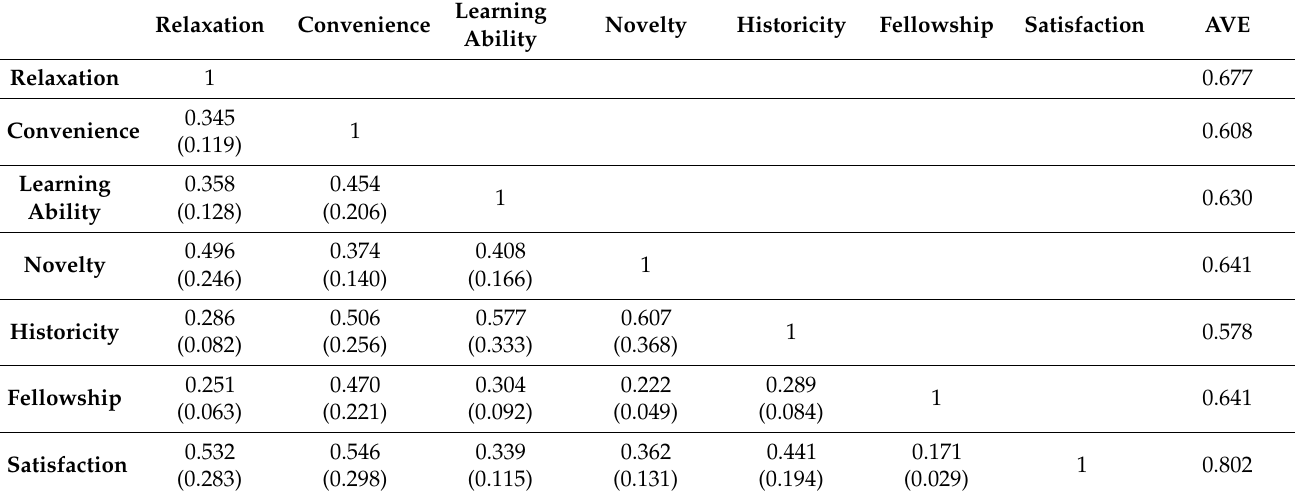
Table 4. Summary of discriminant analysis.